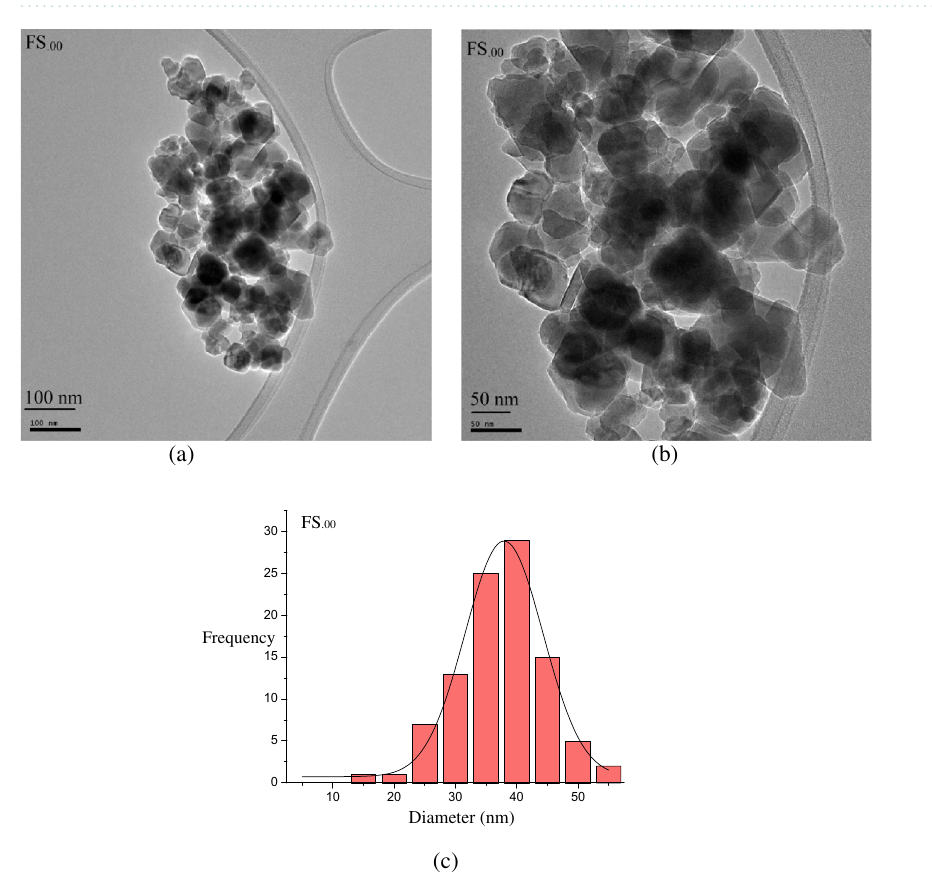
Figure 7. ( a ) and ( b ) TEM images of the FS .00 sample for 2 different magnifications and ( c ) corresponding histogram of the particle size